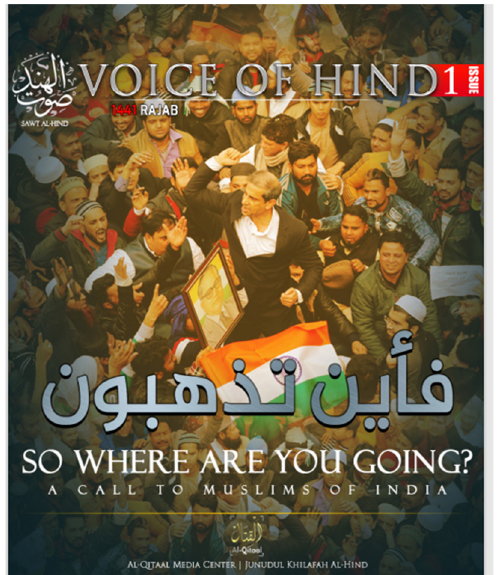
Figure 6. The cover of ISIS’s 1st edition of Voice of Hind, showing Muslim protesters in Delhi. In between these developments in March, a young Kashmiri Muslim couple was arrested in Delhi, with alleged links to IS’s Khorasan province, for instigating anti-CAA protests (PTI 2020b). The police alleged that the couple had moved to Delhi and was actively involved in the publication of the Voice of Hind magazine. According to the counter-terrorist task force, National Investigation Agency (NIA), the couple conspired with other ISIS inspired Indians to create unrest using the anti-CAA protests and highlighting it on social media (Chauhan 2020). The couple’s family denied their involvement with the Islamic State and claimed the arrests were Islamophobic and politically motivated (Azkher 2020).